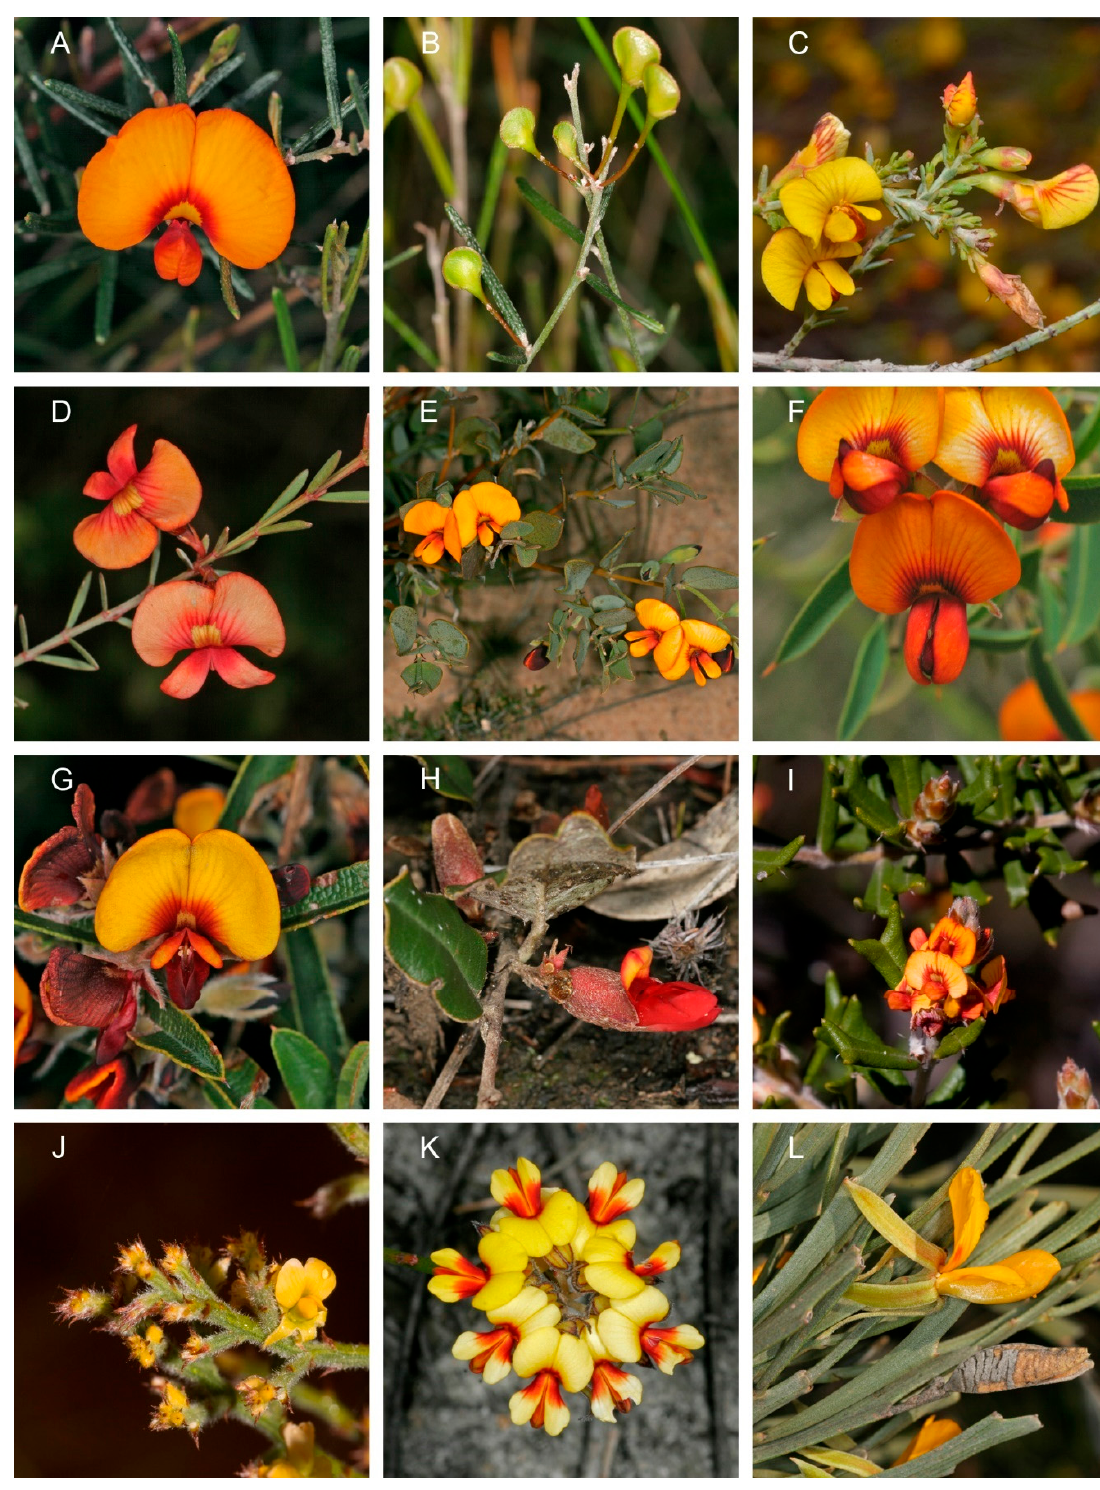
Figure 4. Morphological diversity of representative species from Fabaceae tribe Mirbelieae (core Mirbelieae). ( A , B ) Euchilopsis linearis. ( C ) Eutaxia microphylla . ( D ) Eutaxia virgata . ( E ) Gastrolobium hookeri . ( F ) Gastrolobium propinquum . ( G ) Gastrolobium reticulatum . ( H ) Gastrolobium sericeum . ( I ) Gastrolobium sowardii . ( J ) Jacksonia aculeata . ( K ) Jacksonia capitata . ( L ) Jacksonia compressa . Photographs by Russell Barrett except ( C ), by Murray Fagg (( C ) from the Australian Plant Image Index: http://www.anbg.gov.au/photo (accessed on 11 June 2021)).